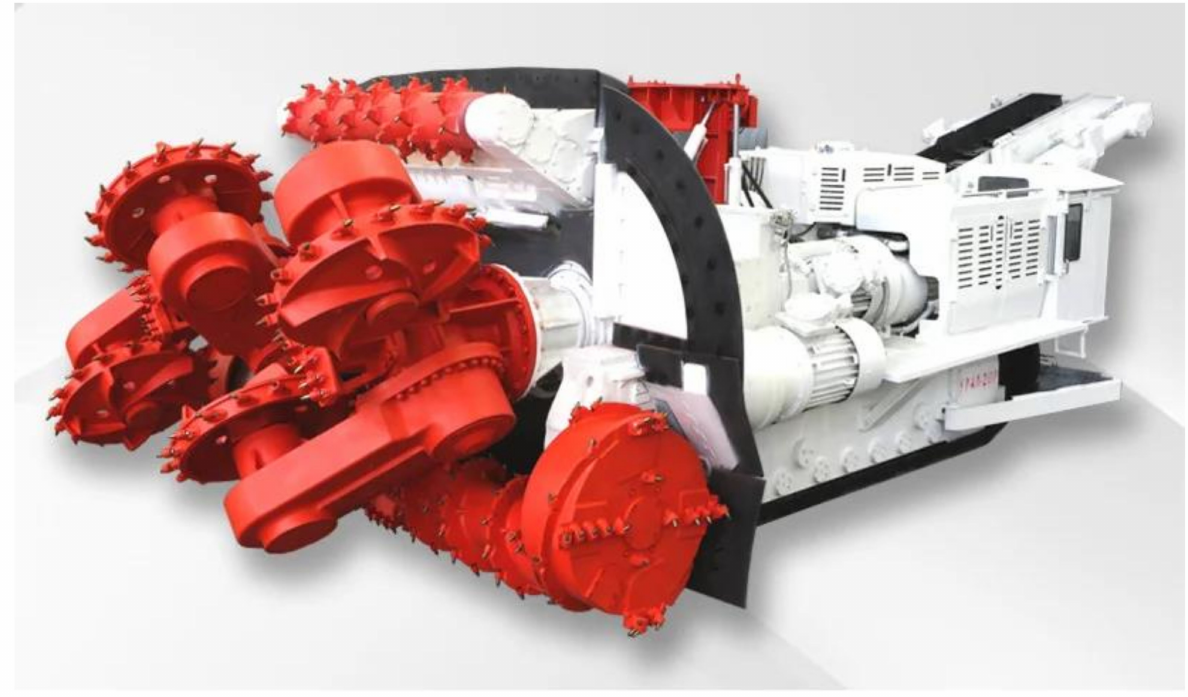
Figure 1. Ural-20R-11 Combine (general